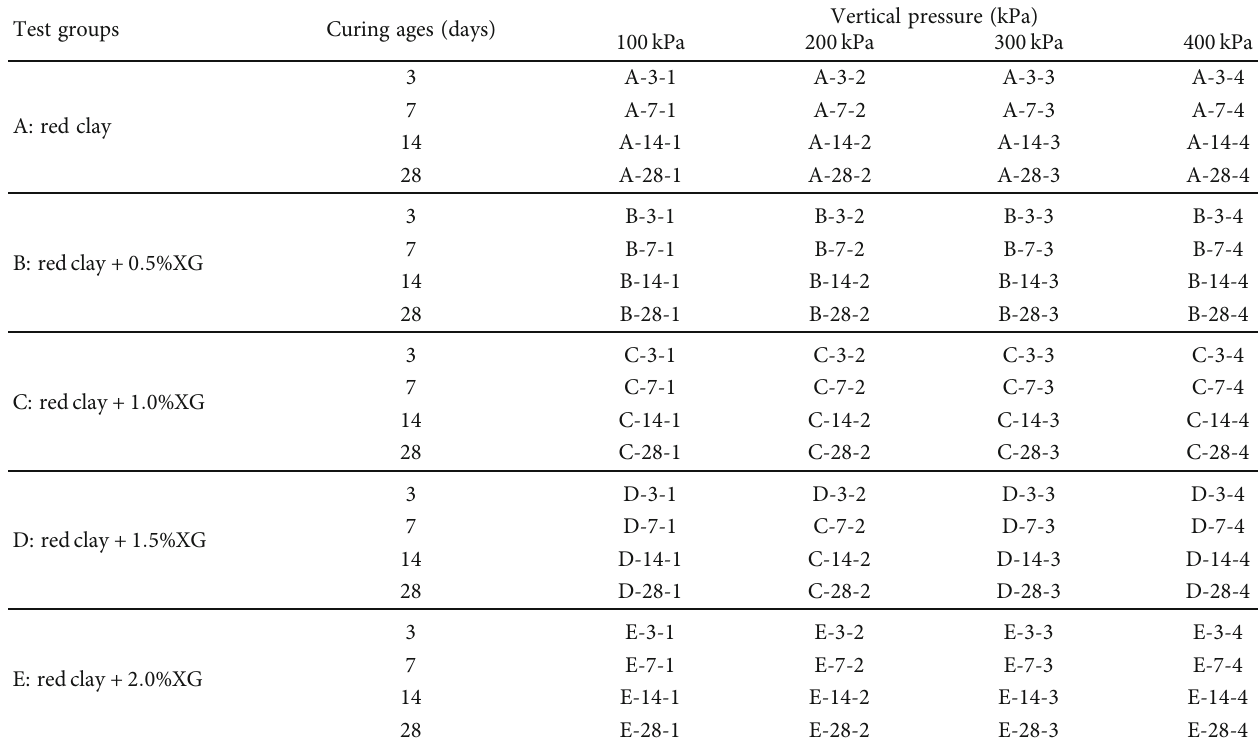
Table 3: Groups and conditions of direct shear